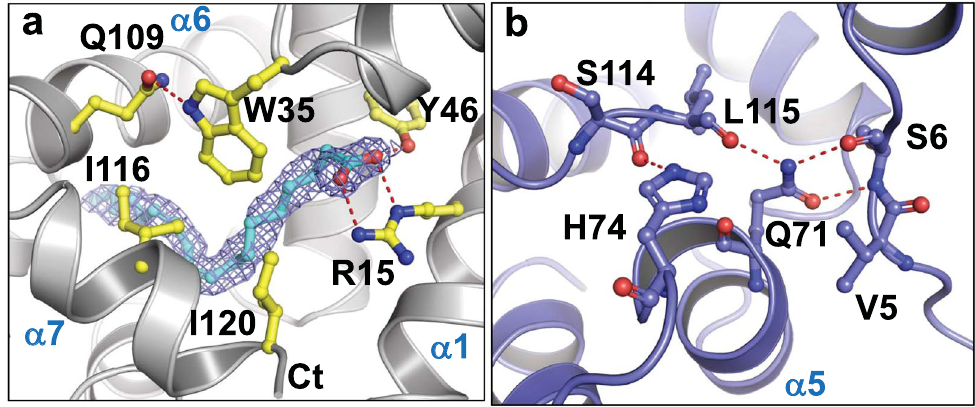
Figure 3. Critical interactions that stabilize the in the bound and apo-states of AeOBP22 (a) Electron density for linoleic acid in a 2Fo-Fc omit map contoured at 1 σ with the fatty acid modelled in cyan. Y46 and R15 make specific H-bonds with the fatty acid. Positioning of the head group is reinforced by interactions with I120, I116, and W35, which H-bonds to Q109 in helix-6. (b) In apo-AeOBP22, the position of the C-terminal tail is stabilized by H-bonds between S114 and L115 with the side chains of H74 in the α 4- α 5 loop and Q71 in helix-4, which in turn forms hydrogen bonds with S6 in the N-terminal